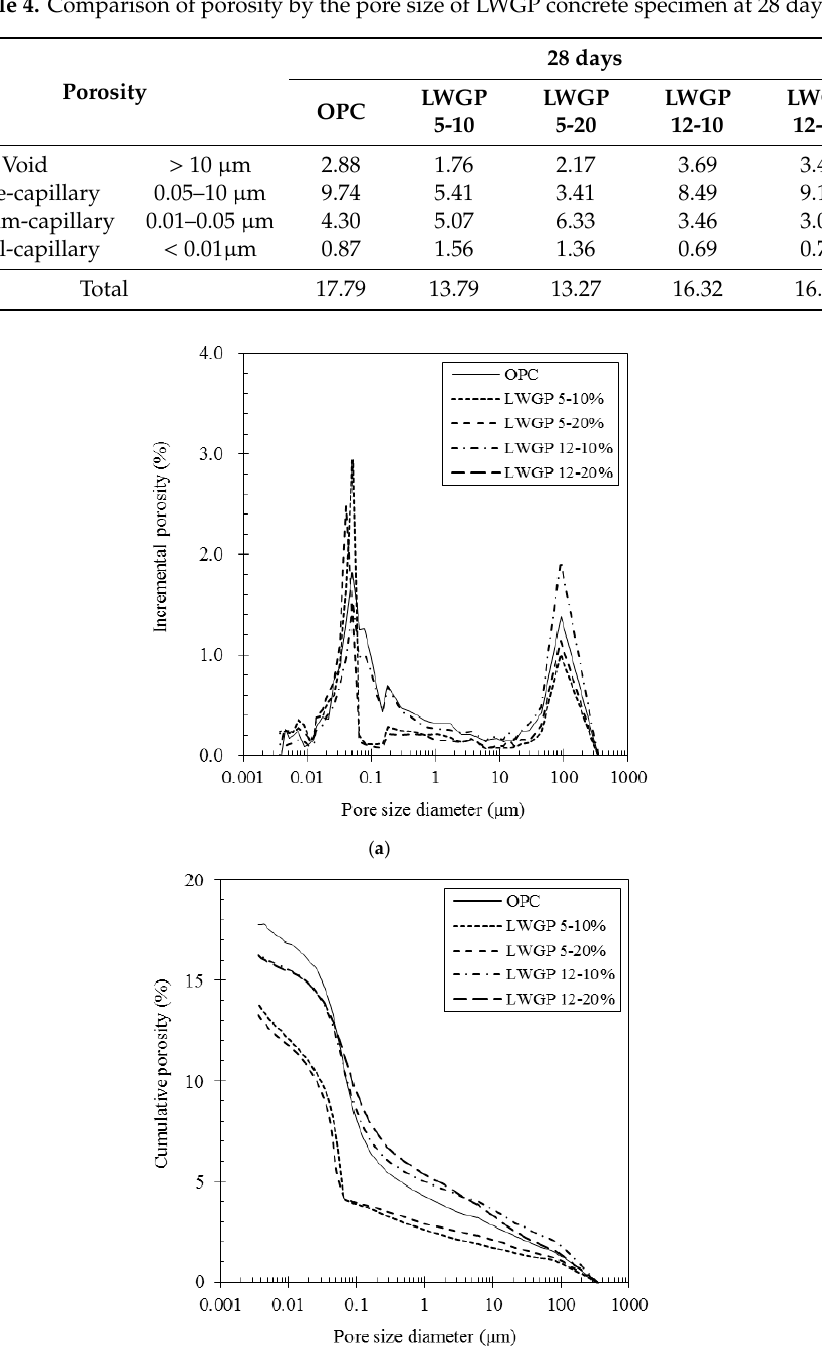
Figure 8. Pore distribution of the specimen obtained from the concrete blended with the LWGP powder. ( a ) The incremental porosity by the pore size diameter; ( b ) The cumulative porosity by the pore size diameter.